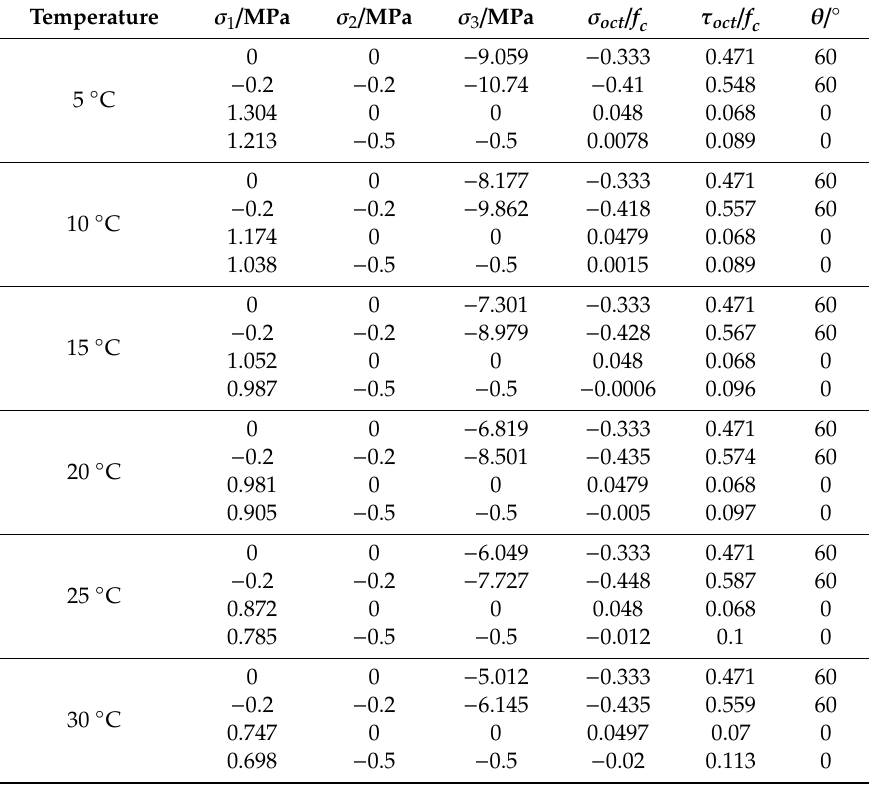
Table 8. Test results of asphalt mixture under di ff erent temperatures.